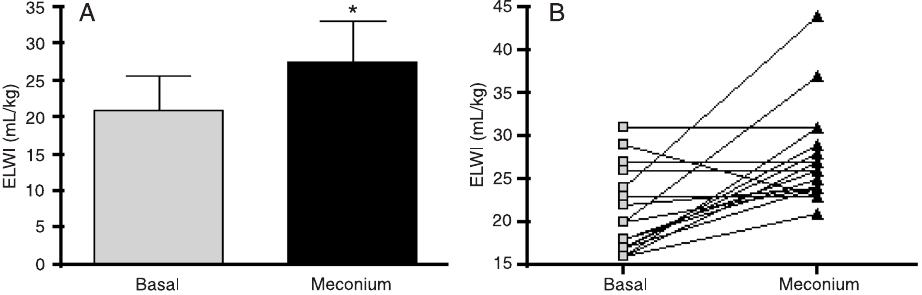
Figure 2. A , Modification of extravascular lung water indexed (ELWI) after meconium aspiration. Data are reported as means ± SD. B , Individual modification of ELWI, pre- and post-meconium. *P < 0.001 compared to basal (Student t-